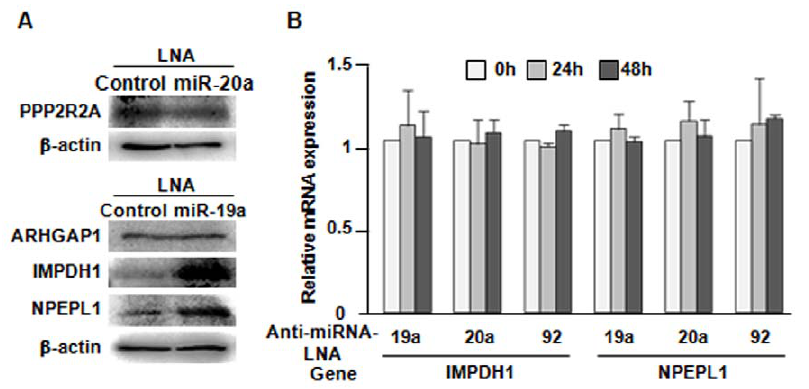
Figure 5. Verification of the candidate targets. (A) Verification of the candidate proteins by a Western blot analysis. The protein extracts from MCF-7 cells treated with the anti-miRNA-LNA or control-LNA were evaluated. (B) The effect of the miRNAs on the levels of IMPDH1 and NPEPL1 mRNAs. The expression of the mRNAs in the anti-miRNA-LNA-treated groups was compared to that in the control LNA-treated group by quantitative real-time PCR. The miRNA inhibition by the anti-miRNA-LNA had no significant effect on either the IMPDH1 or NPEPL1 mRNA levels from 24 to 72 hours after transfection. The data are shown as the means + SD.